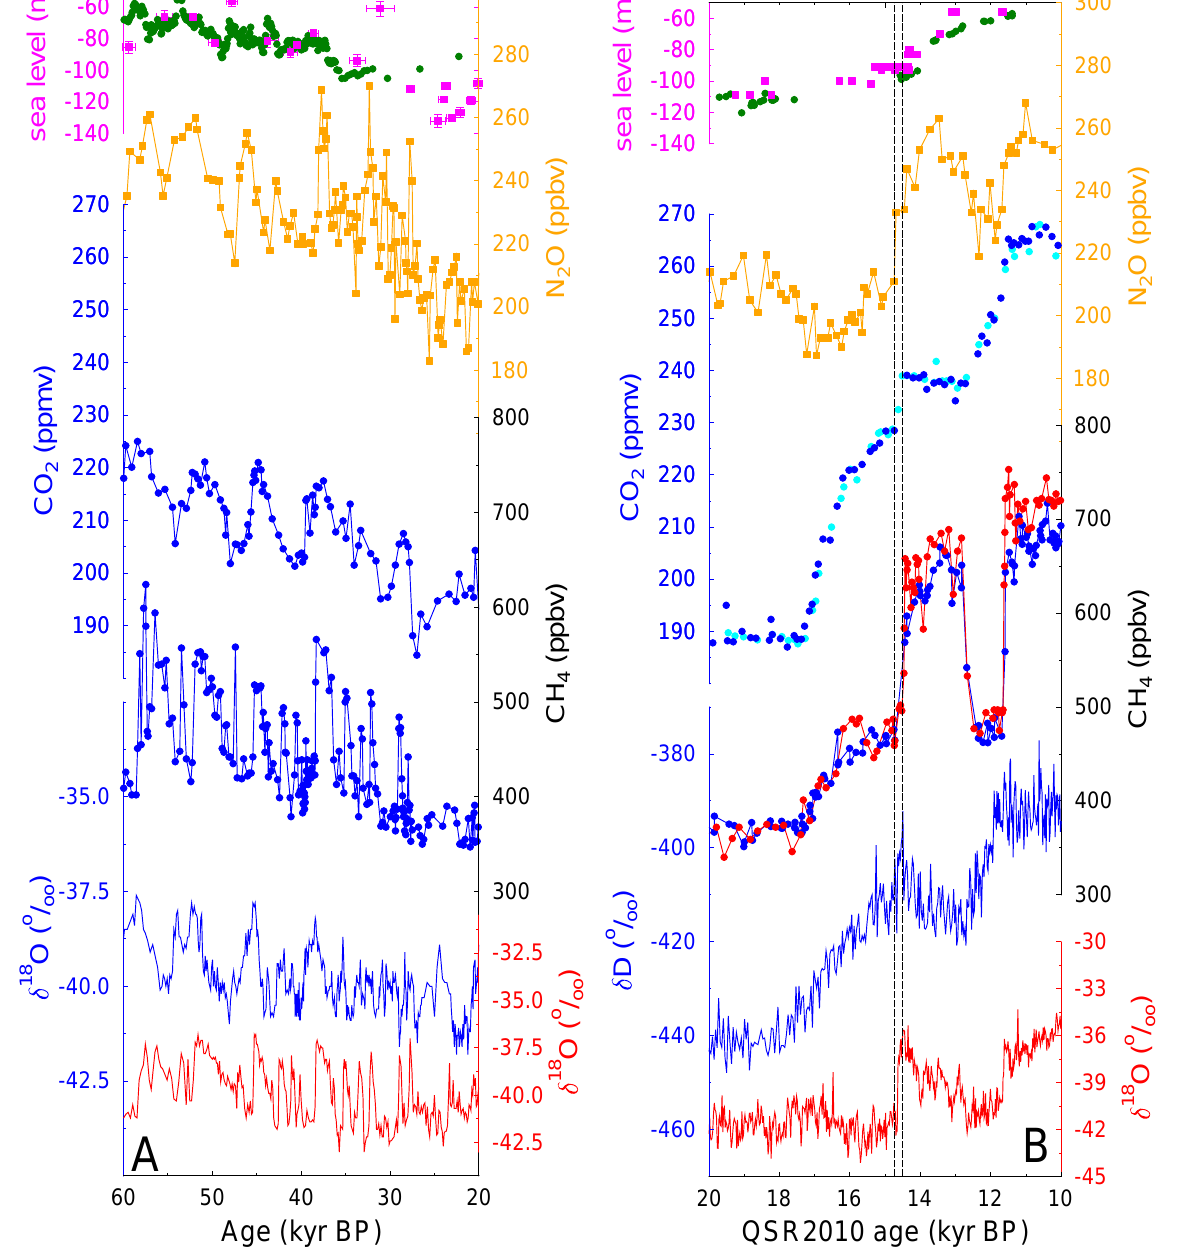
Fig. 1. Climate records during MIS 3 and Termination I. From top to bottom: relative sea level, N 2 O, CO 2 , CH 4 and isotopic temperature proxies ( δ D or δ 18 O) from Antarctica (blue) and Greenland (red). (A) MIS 3 data from the Byrd (CO 2 , CH 4 , δ 18 O), GISP2 (Ahn and Brook, 2008) and Talos Dome ice cores (N 2 O) (Schilt et al., 2010). Sea level from a compilation (magenta) based on coral reef terraces (Thompson and Goldstein, 2007) and the synthesis (green) from the Red Sea method (Siddall et al., 2008). Age model of Byrd and GISP2 as in Ahn and Brook (2008) and Talos Dome data on the TALDICE-1 age scale (Buiron et al., 2011). (B) Termination I data from the EDC (blue, cyan: CO 2 , CH 4 , δ D), Talos Dome (N 2 O) and NGRIP (red: CH 4 , δ 18 O) ice cores (Monnin et al., 2001; Stenni et al., 2001; NorthGRIP- members, 2004; Lourantou et al., 2010; Schilt et al., 2010). Previous (Monnin et al., 2001) (blue) and new (Lourantou et al., 2010) (cyan) EDC CO 2 data. Sea level in from corals (green) on Barbados, U-Th dated and uplift-corrected (Peltier and Fairbanks, 2007), and coast line migration (magenta) on the Sunda Shelf (Hanebuth et al., 2000). In (B) sea level is plotted on an individual age scale, N 2 O on TALDICE-1 age scale of Talos Dome (Buiron et al., 2011), and EDC and NGRIP data are plotted on the new synchronised ice core age scale QSR2010 (Lemieux-Dudon et al., 2010). Vertical lines in (B) mark the jump in CO 2 into the B/A as recorded in